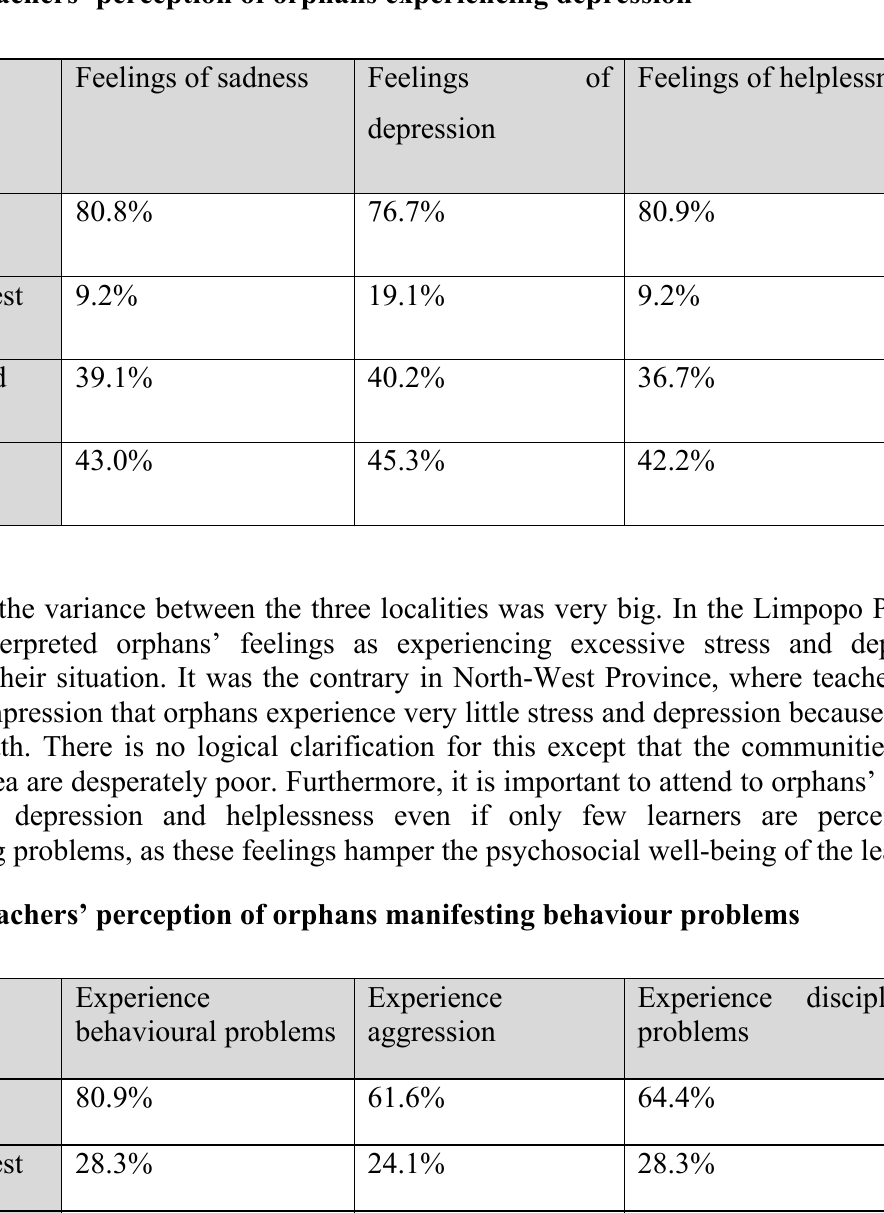
Table 5. Teachers’ perception of orphans experiencing depression